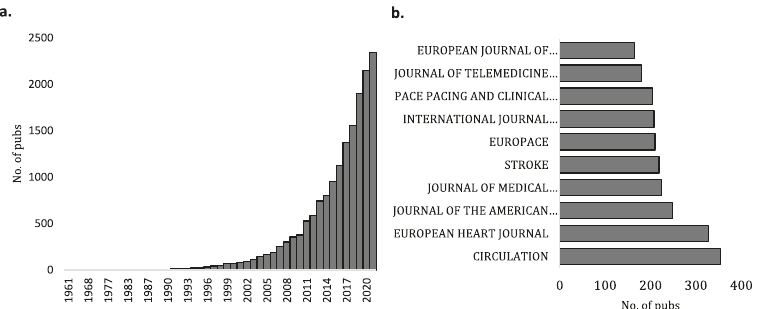
Fig. 1 Years of publication and major sources. a Distribution of digital technology research articles (in cardiovascular medicine) from 1961 to 2021; b Major journals within the topic of digital technology applications in cardiovascular